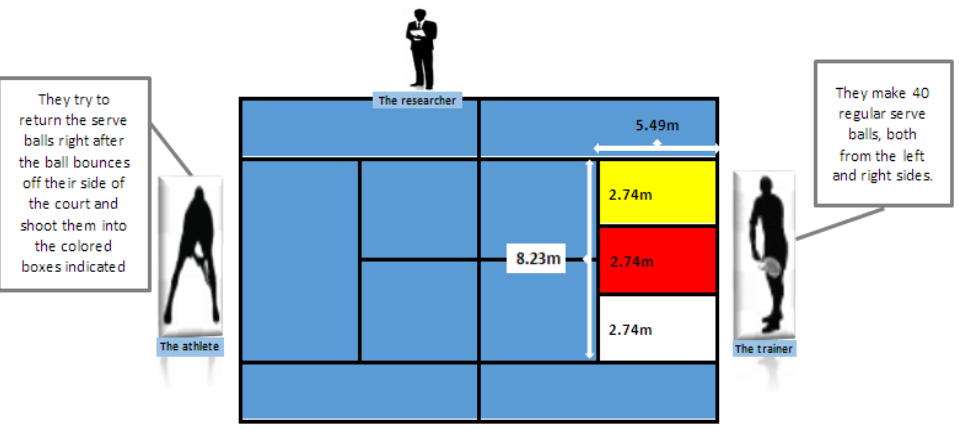
Figure 1. The design of the training.